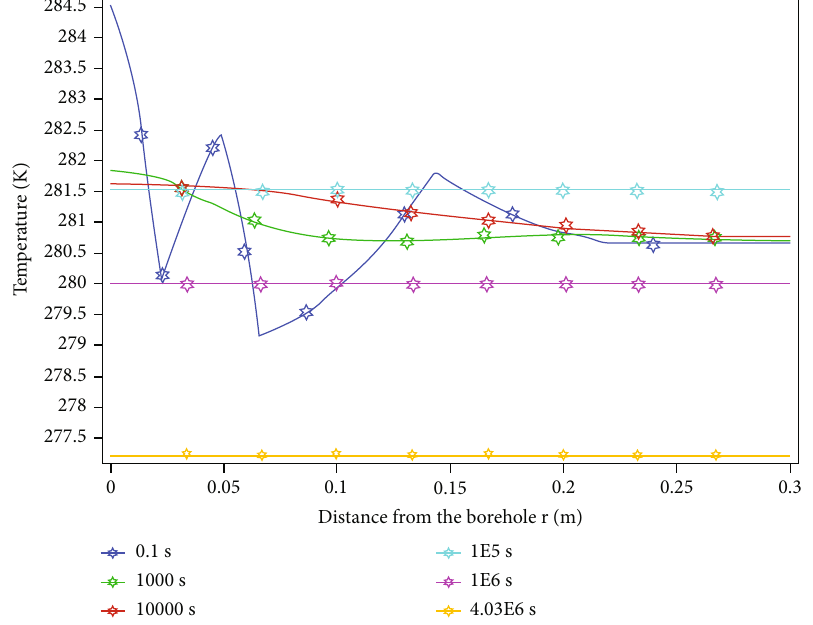
Figure 26: Temperature in the m = 1 coal rock during CBM